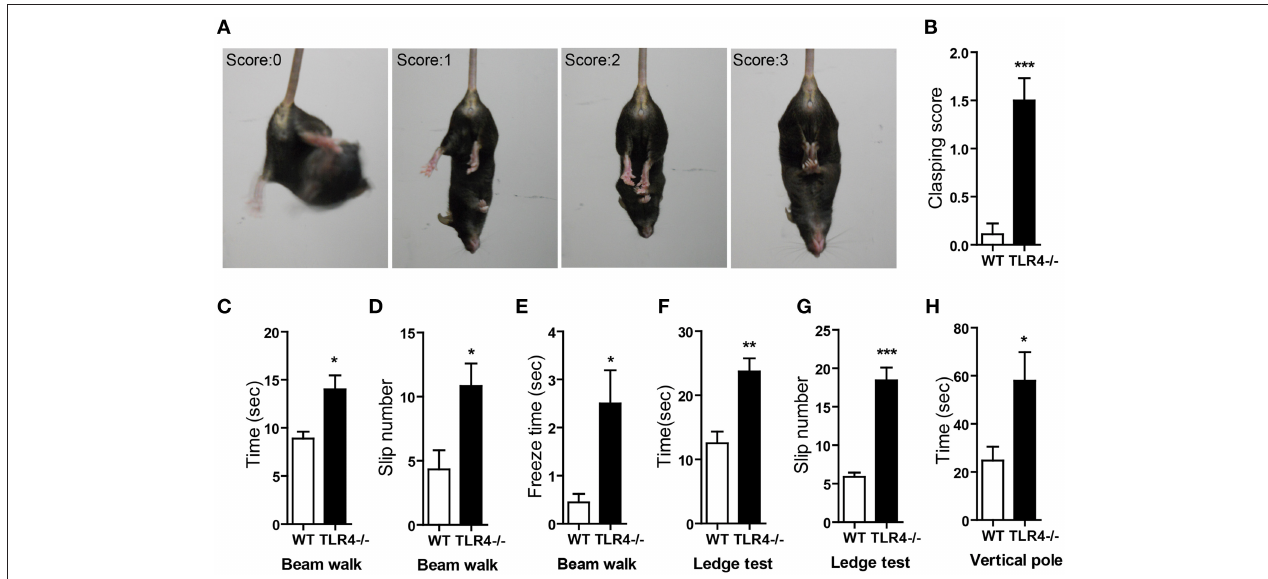
FIGURE 3 | TLR4 deficiency impairs motor coordination. (A) Representative posture and scoring in the hindlimb clasping test. (B) Quantitative analysis the hindlimb clasping scores; TLR4 − / − mice showed higher scores than WT mice. (C–E) Results of the beam walk test. TLR4 − / − mice took longer to cross the beam (C) , had a greater number of slips (D) , and exhibited longer freeze times (E) during beam crossing than WT mice. (F,G) Results of the ledge test. TLR4 − / − mice took longer to cross the ledge (F) and had a greater number of slips (G) than WT mice when walking along the ledge. (H) Results of the hangwire test showed that TLR4 − / − mice took longer to turn around and climb down the wire than WT mice. Data are presented as mean ± SEM ( n = 9 –12 mice/group). * P < 0.05 , ** P < 0.01 , *** P < 0.001 .